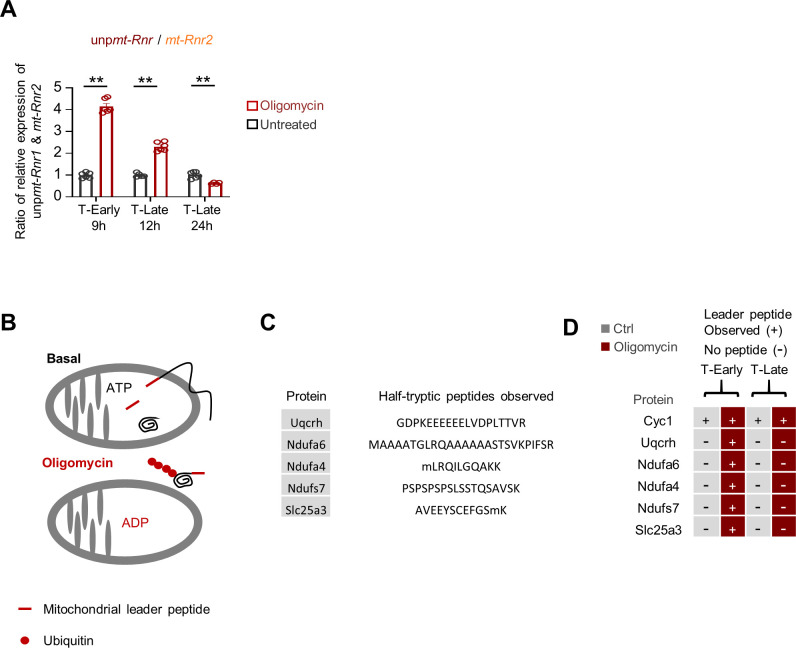
Respiratory restriction induces an energetic crisis within the matrix compartment in early activated CD8+ T Cell.A) Splenocytes were stimulated using anti CD3/CD28 for 9, 12 and 24 hr. Cells were then treated with oligomycin for one hour or left untreated. Isolated CD8+ T cells were then analyzed using qRT-PCR for unprocessed mt-Rnr transcript (unpmt-Rnr) and its two processed products, mt-Rnr1 and mt-Rnr2. Figure shows ratio between the relative expression of unpmt-Rnr and mt-Rnr1. (n = 6 biological replicates, P value ** 0.0022 ** 0.0043 ** 0.0095). (B) Schematic describing the way matrix ATP deficiency leads to accumulation of ubiquitinated mitochondrial matrix-localized proteins and pre-proteins. (C-D) Splenocytes were stimulated using anti CD3/CD28 for 9 or 12 hr (T-Early and T-Late respectively). One hour prior to CD8+ T cells isolation, cells were treated with oligomycin or left untreated. Protein extracts from isolated CD8+ T cells were then subjected to immunoprecipitation using anti-ubiquitin antibody. Sample analysis was performed by MS focusing on leader peptides. (C) Table shows sequences of leader peptides and their corresponding proteins identified in T-Early and T-Late in respect to untreated samples. (D) Comparison of the presence of leader peptides identified in T-Early and T-Late. Statistical method, non-parametric Mann-Whitney test, mean ± s.e.m.